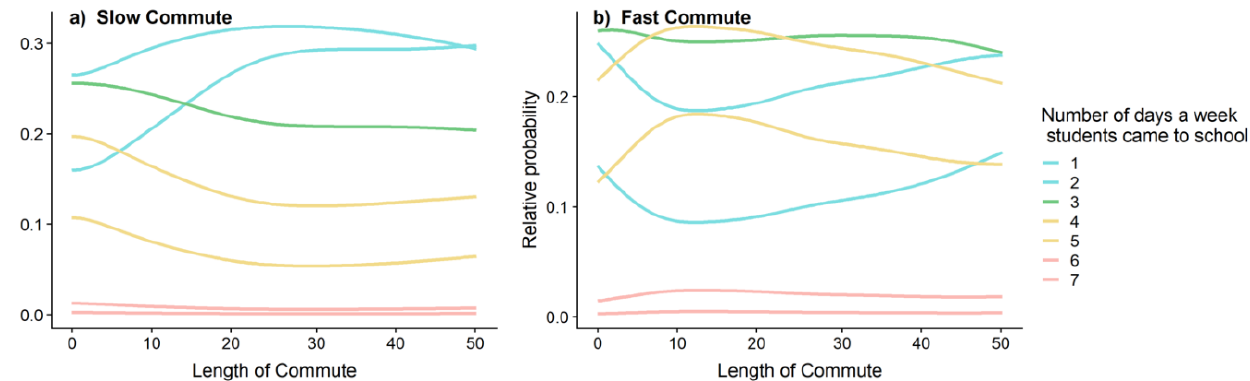
Figure 4. Posterior probability estimates for number of days of the week commuting to campus as a function of commute distance for a ( a ) slow commute and ( b ) fast commute, for different number of weekdays the student visited campus. Estimate represents the probability of visiting campus a specific number of times per week, as denoted by line